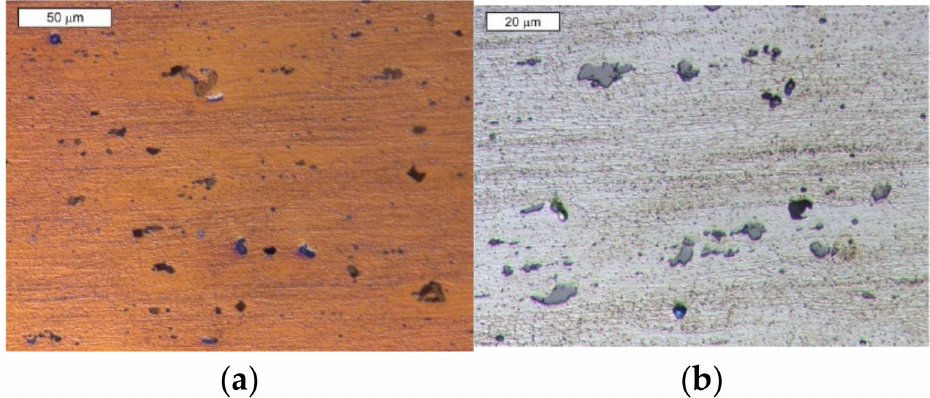
Figure 6. Magnified image of the alloy microstructure in the T6 state: ( a ) DIC contrast and ( b ) bright-field (BF). Etched state, light